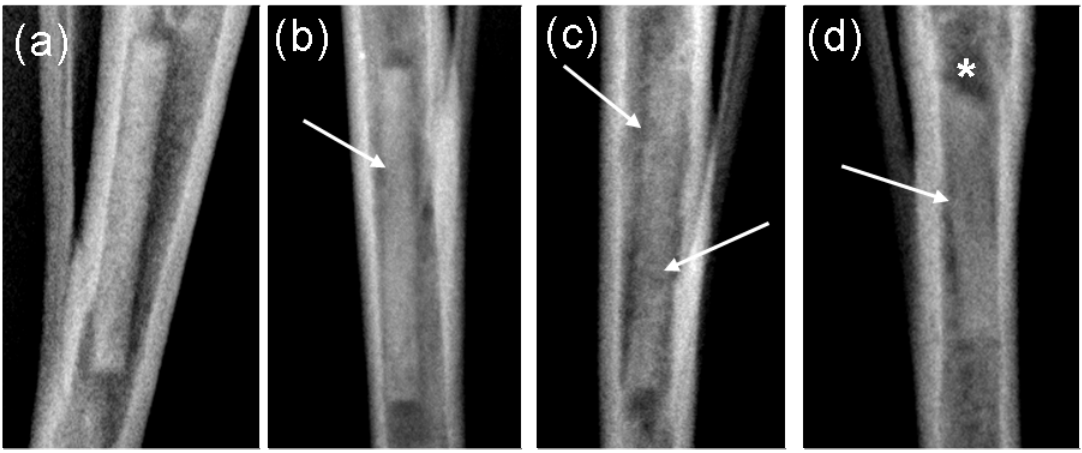
Figure 12. Assessment of the implant’s degradation by means of anterior-posterior x-ray images: ( a ) Score 0: as on the day of implantation; ( b ) Score 1: low structural loss without shape change; ( c ) Score 2: marked structural loss without shape change; ( d ) Score 3; significant structural loss with shape change. Arrows indicate the structural loss, stars indicate shape